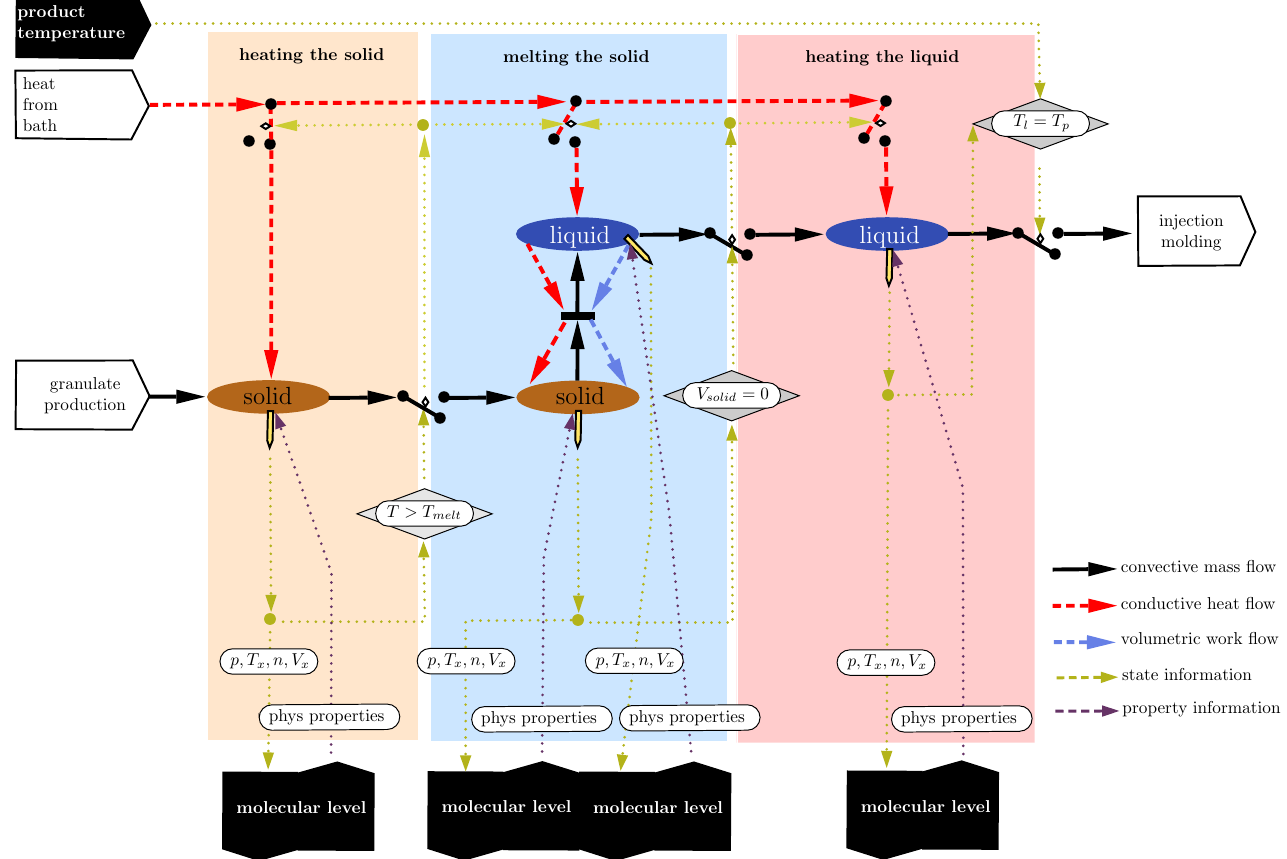
Figure 11. A generic melting process demonstrating how the model switching is included in the model, leading to a surprisingly complicated overall